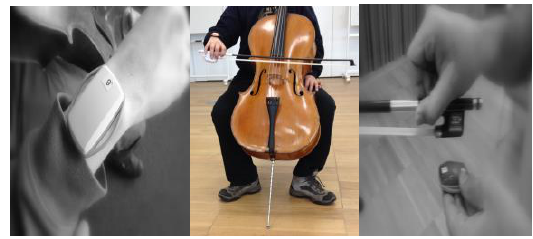
Figure 1: Cellist (Centre) with an Orient Speck attached to the wrist (Left) and another one attached to the frog of the bow